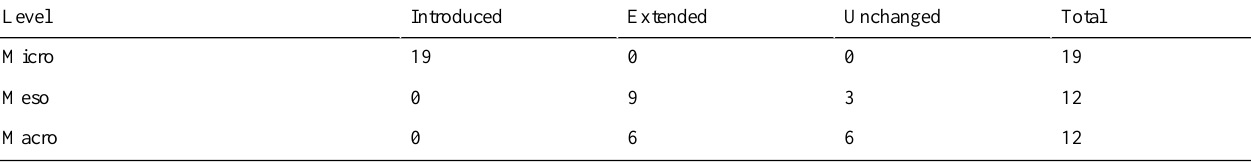
Table 1. The number of categories with introduced, extended, and unchanged definitions per level.